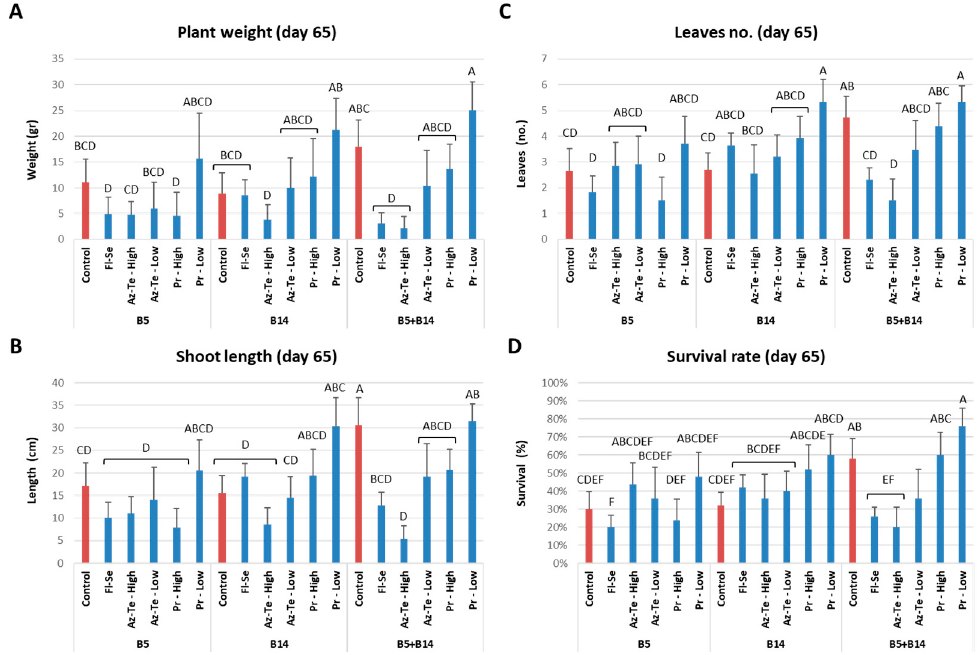
Figure 4. Effect of pesticide treatments on the growth indexes and survival of white onion plants (Orlando cv.) 65 days after soil surface germination. The experiment and abbreviations are described in Figure 2. The mid-season evaluation included the plants’ weight ( A ), shoot length ( B ), and phenological development (number of leaves, C ). Each value is an average of four plants/pot. The survival rate ( D ) is the percentage of five plants/pot. B5- F. acutatum , B14- F. oxysporum f. sp. cepae . Bars indicate the mean of five (Prochloraz and Az-Te) or 10 (Fl-Se) biological replications (pots). Controls (red columns) are plants without fungicides. Error bars are standard errors. Different letters above the chart's bars (A–F) represent a significant difference ( p < 0.05) in the ANOVA test.